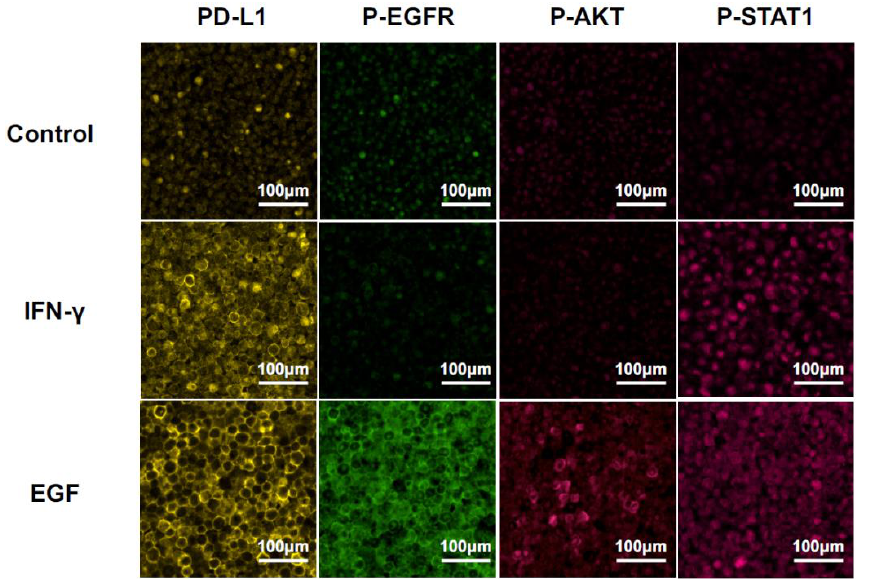
Figure 3. Changes in MF-IHC staining for PD-L1, p-EGFR, p-AKT, and p-STAT1 by EGF and IFN- γ stimulation of HSC3. HSC3 was stimulated with EGF or IFN - γ for 24 h, and we investigated changes in the MF-IHC staining for PD-L1, p-EGFR, p-AKT, and p-STAT1. Scale bars are indicated in each image.